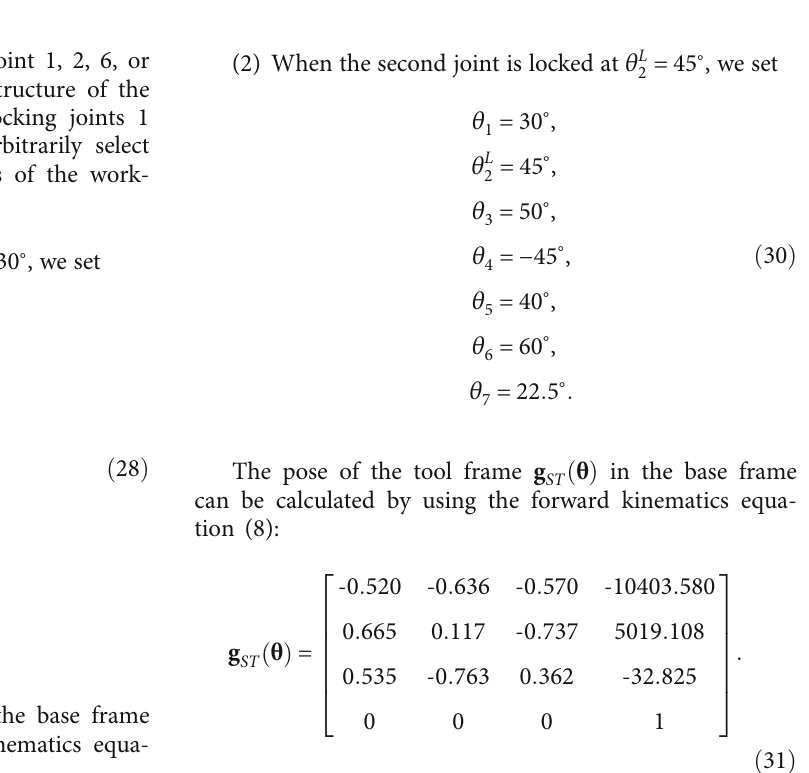
Figure 10: Motion planning simulation